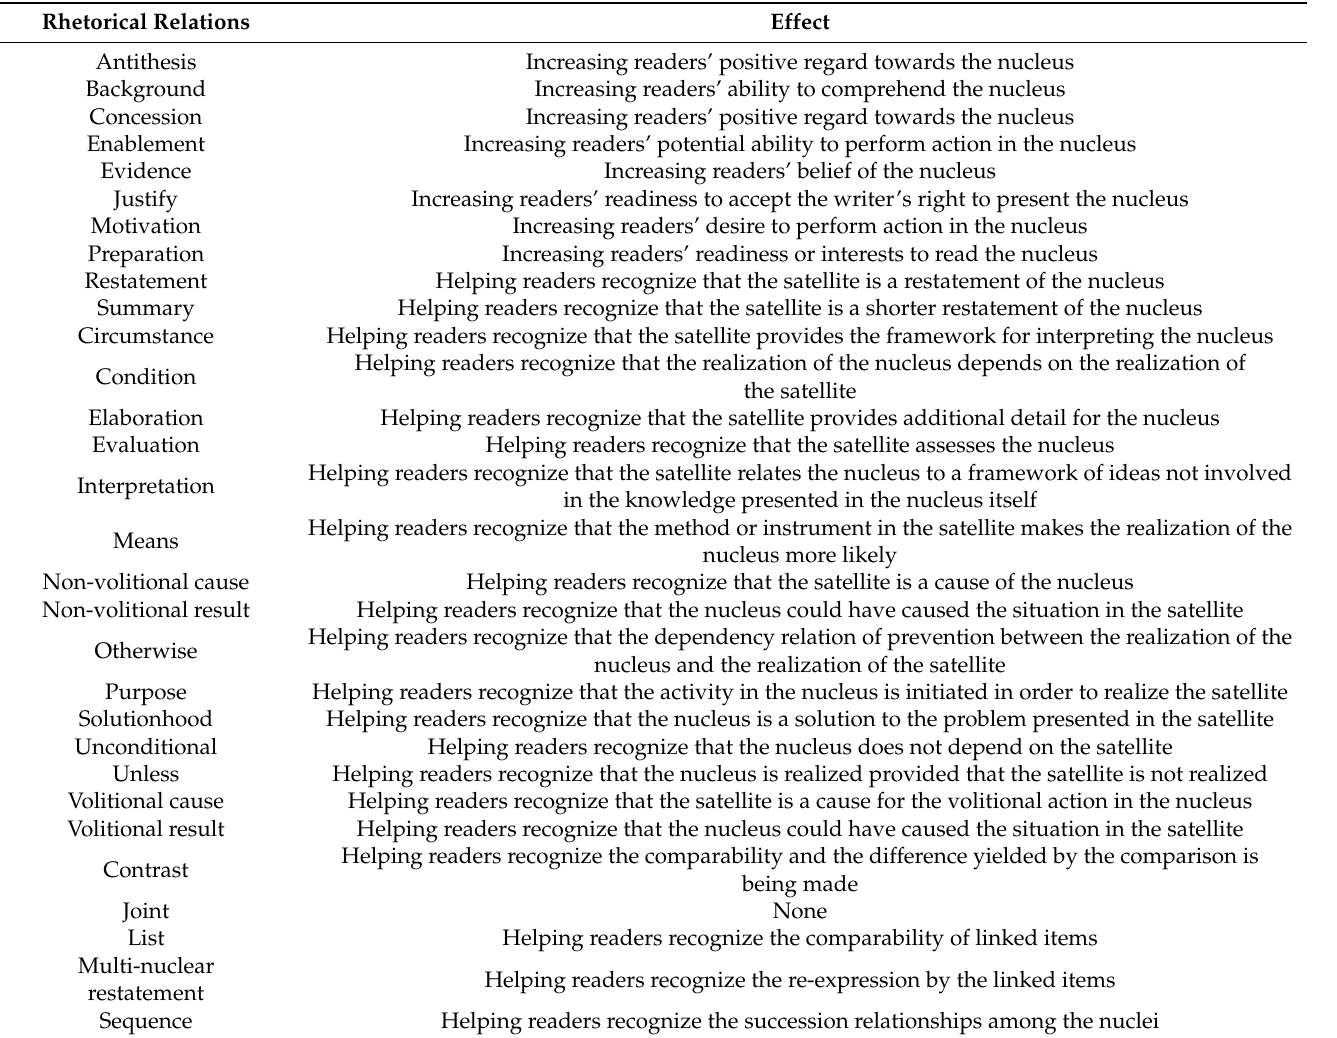
Table 1. Effects of the thirty rhetorical